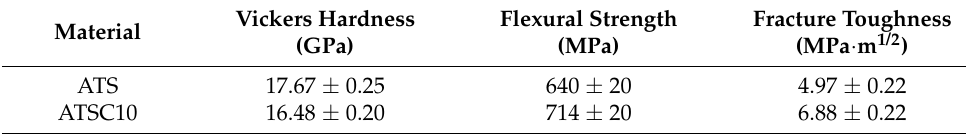
Table 3. Mechanical properties of ceramic tool materials.